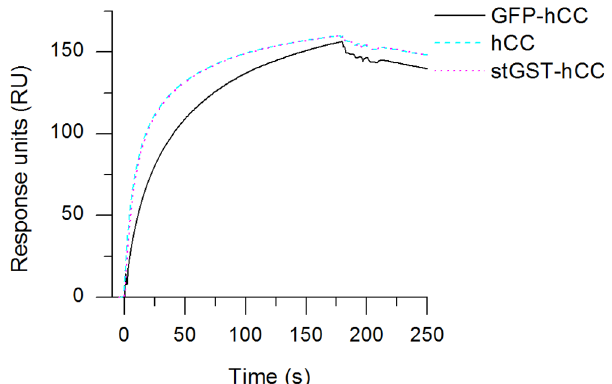
Fig 4. SPR analysis of mAb CyDI-4 based on its ability to bind and release hCC and hCC fusion proteins. Purified mAb CyDI-4 was captured to a response of ~150 RU and hCC/hCC fusion proteins were applied at a concentration of 10 μ g/ml for 180 s followed by dissociation. The three tested proteins are shown in different colours.